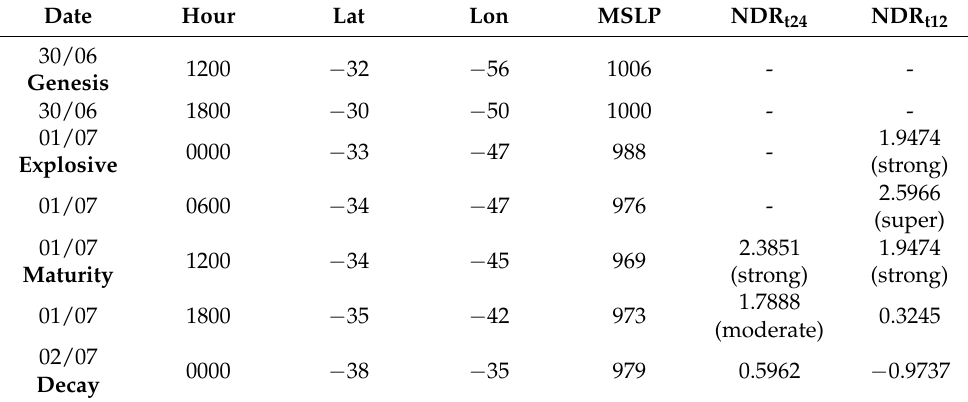
Table 3. Cyclone lifecycle: latitude, longitude, MSLP (hPa) at the cyclone center, and NDR every 6 h (UTC). NDR t24 and NDR t12 follow SG [1] and Zhang et al. [2], respectively. The dates of genesis, explosive phase, maturity, and decay are also